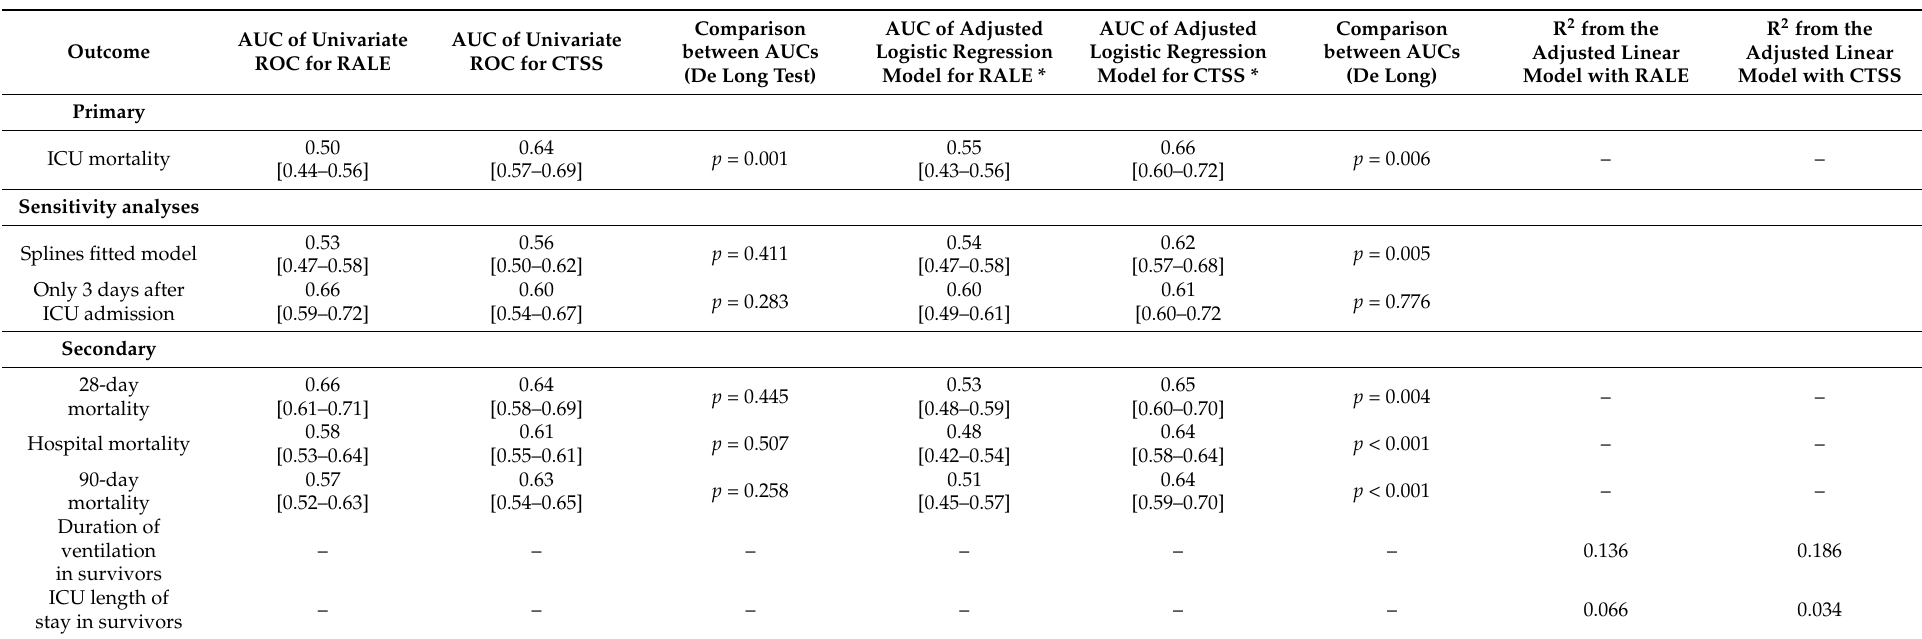
Table 4. Comparison of prognostic capacity across primary and secondary outcomes between the two imaging